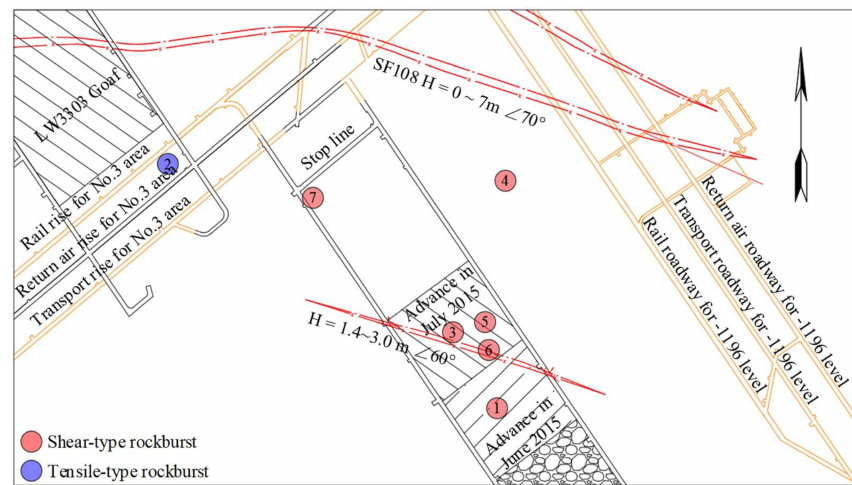
Figure 10. LW3302 layout and rock bursts distribution in Xingcun Coal Mine.